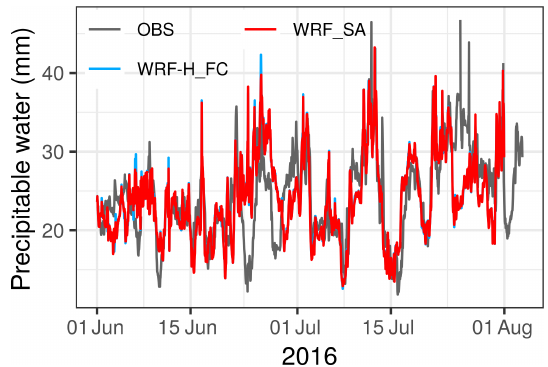
Figure 13. Simulated and observed precipitable water for the